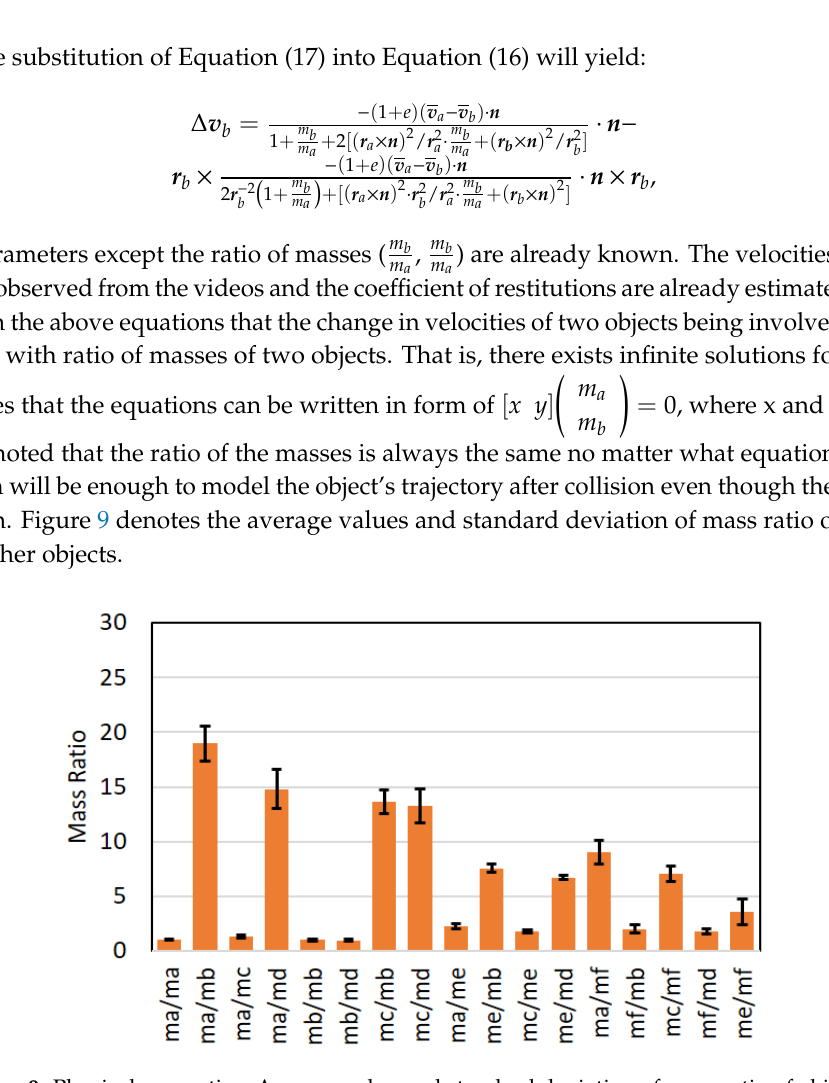
Figure 9. Physical properties. Average value and standard deviation of mass ratio of objects.